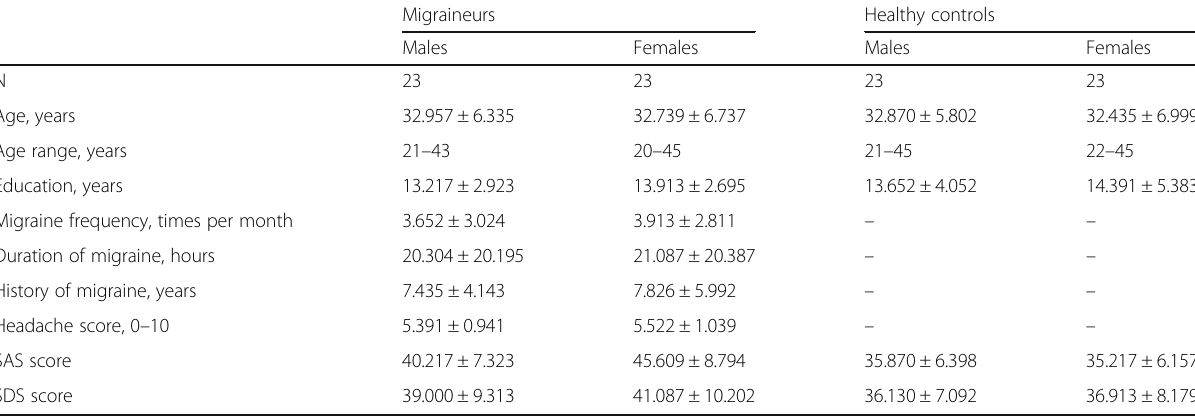
Table 2 Subject characteristics